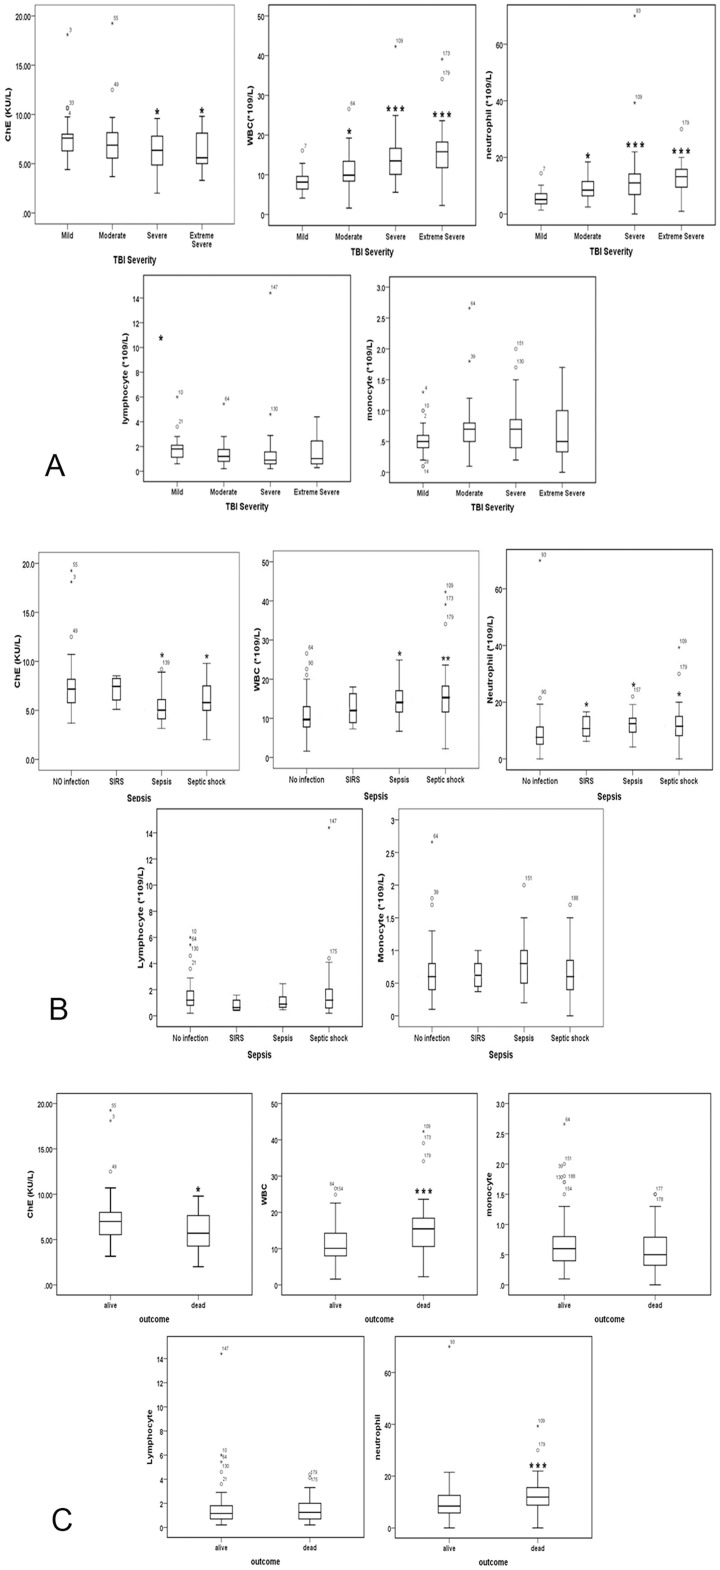
Admission ChE activity and blood cell counts in TBI patients as classified according to the severity (A), infected status (B), and the outcome (C).Boxes represented lower, median (line) and upper quartiles; whiskers showed the range of the data excluding outliers (。). *P<0.05, **P<0.01, ***P<0.001, compared with corresponding mild (A), non-infection (B) and survived (C) patients as analyzed by nonparametric test of several independent samples test (The Kruskal-Wallis H test).